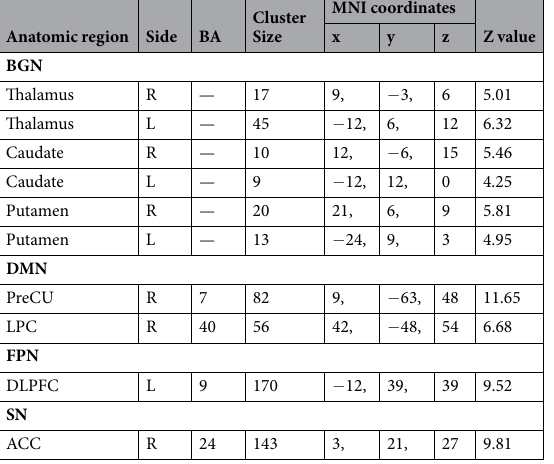
Table 2. Comparisons of intranetwork connectivity among dPD, ndPD and HC groups (one-way ANOVA, p < 0.05, topoFDR corrected). L, left; R, right; BA, Brodman area; MNI, Montreal Neuroscience Institute template; BGN, basal ganglia network; DMN, default-mode network; FPN, frontoparietal network; SN, salience network; LPC, Lateral parietal cortex; DLPFC, dorsolateral prefrontal cortex; ACC, anterior cingulate